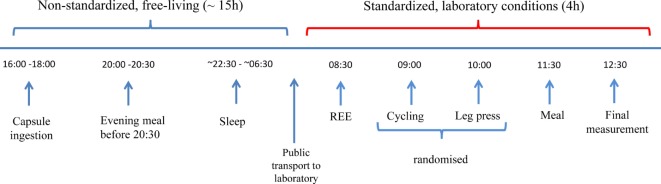
Study design. Capsules were ingested prior to 18:00 the night before the experiment. Subjects were instructed to take their evening meal no later than 12 h before their scheduled test the following morning to ensure all subjects were fasted for ~12 h. Subjects were given instructions on when to go to bed and to wake up the next morning and were advised to take motorized/public transport to the laboratory. Following a rest period, baseline resting energy expenditure (REE) measurements were taken for 30 min, followed by a series of low-intensity exercise tests, and followed by a 600 kcal mixed meal.